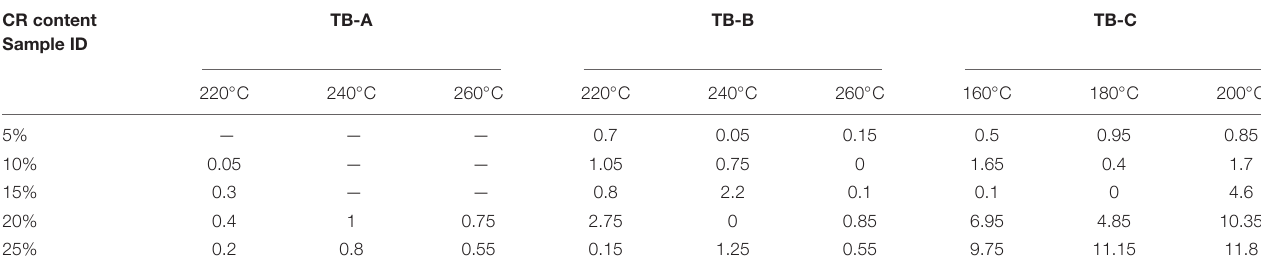
TABLE 4 | Softening point difference of TB asphalt ( ◦ C).